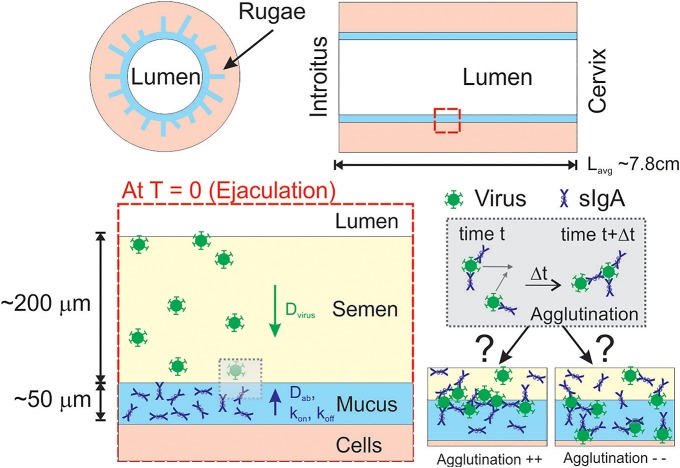
Schematic of our model.The schematic depicts diffusion of HIV from seminal secretions across the cervicovaginal mucus (CVM) layer containing HIV-binding sIgA en route to the underlying vaginal epithelium. For sIgA-induced agglutination to occur, virions must collide with each other. Virions and antibodies are not drawn to scale.